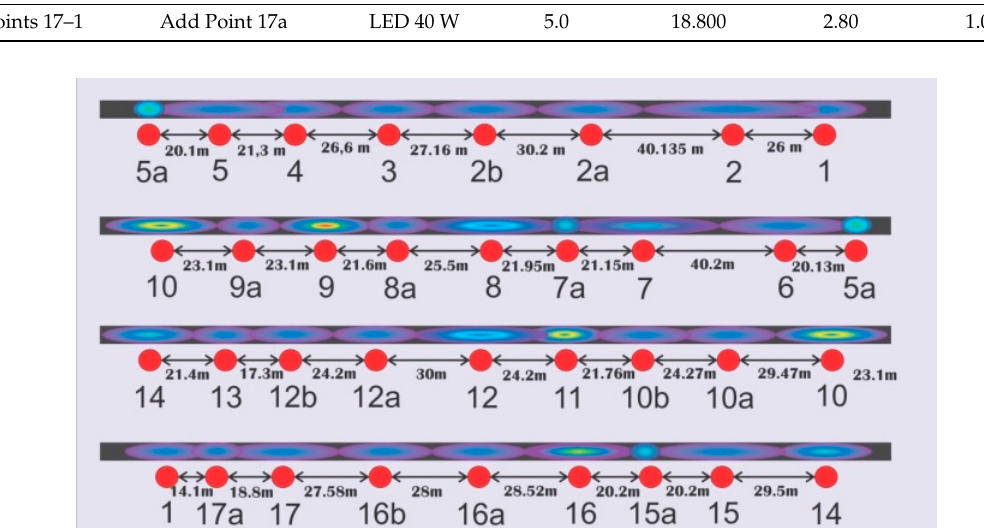
Figure 8. Illumination simulation of Alternative 2.